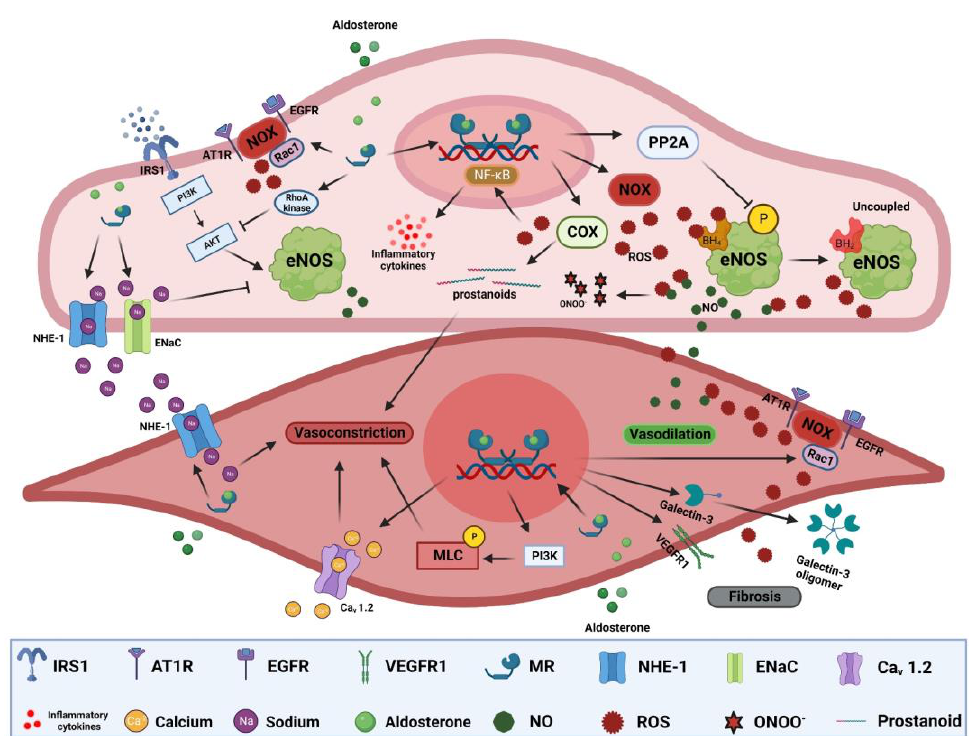
Figure 2. MR-mediated mechanisms of vascular dysfunction. MR activation in endothelial cells can induce ROS production through activation of NOXs and COXs. ROS react with NO, reducing its bioavailability leading to impaired endothelial-dependent vasodilation, forming a more reactive nitrogen species, ONOO-, oxidizing BH 4 to uncouple eNOS that leads to production of ROS instead of NO. Excessive ROS production can also trigger NF- ƙ B activation, leading to increased expression of inflammatory cytokines. MR activation can also inhibit eNOS through dephosphorylation by PP2A, impair insulin-dependent signaling, activate NHE-1 and EnaC. In SMCs, MR activation can trigger vasoconstriction through activation of NHE-1 and Ca v 1.2 in addition to MLC phosphorylation. Activation of MR can elicit fibrotic signaling through increased ROS production, galectin-3 oligomer formation, and VEGEF signaling. Akt: protein kinase B, AT1R: type I angiotensin receptor,